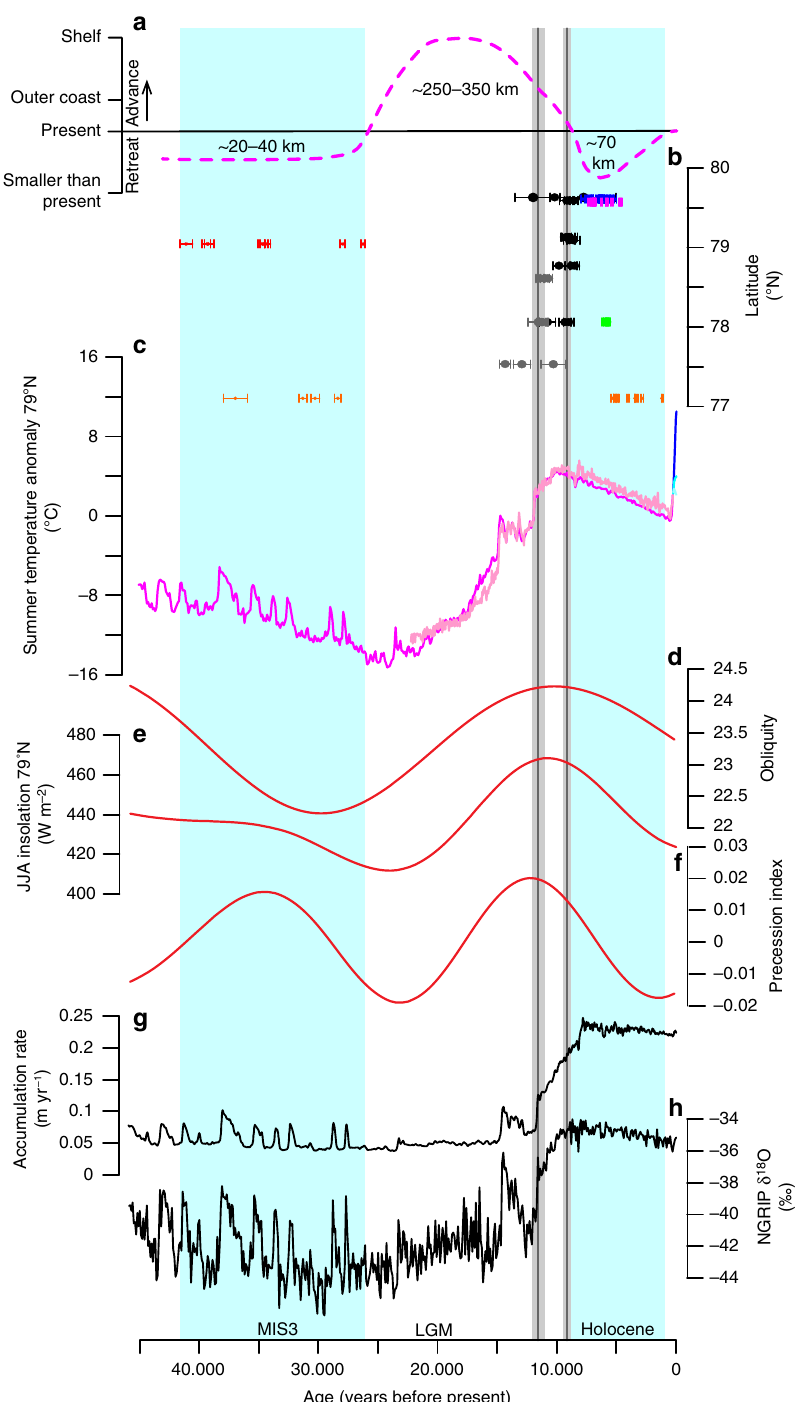
Fig. 3 Ice and climate fl uctuations of the Northeast Greenland Ice Stream for the last 45 kyr. a Reconstruction of ice-margin fl uctuations based on b 10 Be ages with external uncertainties from outer coast (dark gray) and outside the Little Ice Age moraine (black), and 14 C dates from raised marine deposits presently dammed by NEGIS up to 70 km upstream the present ice margin at NG; Blåsø (blue) 27 and Midgaardsormen (pink) 27 , and 14 C dates of reworked shells in Little Ice Age moraines at Søndre Mellemland (green) 27 , and at SG (orange) 28 . Vertical gray bars are the mean and standard error of the outer (older) and inner (younger) 10 Be ages with the production rate uncertainty included. Vertical light blue bars are when the NEGIS is smaller than present. c Reconstructed summer temperature (pink) with RCP 2.6 (light blue), 4.5 (blue), and 8.5 scenarios (dark blue) at 79°N 31 and a summer temperatures reconstruction (magenta) based on a multiple-regression method (see Methods). d – f Orbital parameters and summer insolation at 79°N. g Accumulation rate at NEEM 36 . h Ice core δ 18 O record from NGRIP